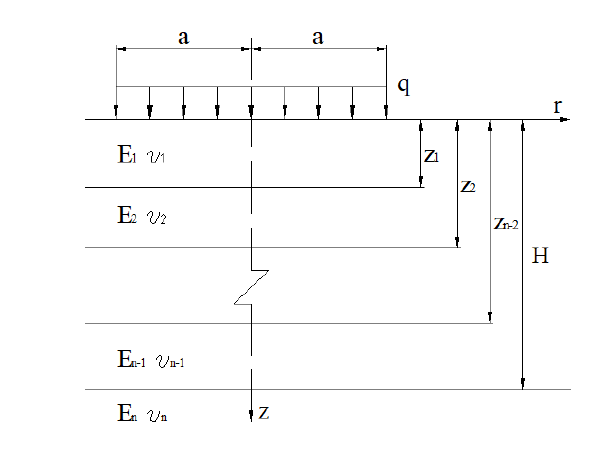
Figure 5: Burmister’s multi-layer system to compute stress and strain in each layer [6].